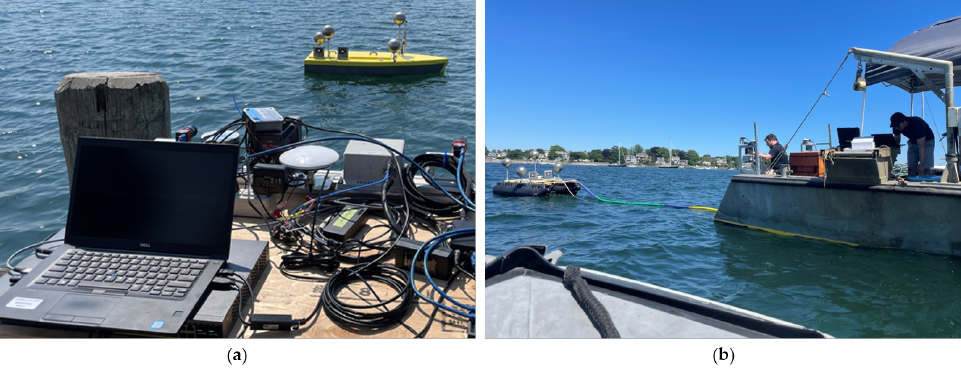
Figure 16. Initial sea testing of custom ASVs and sensors. Precision optical and LiDAR tracking of the vessel from shore ( a ) and boat ( b